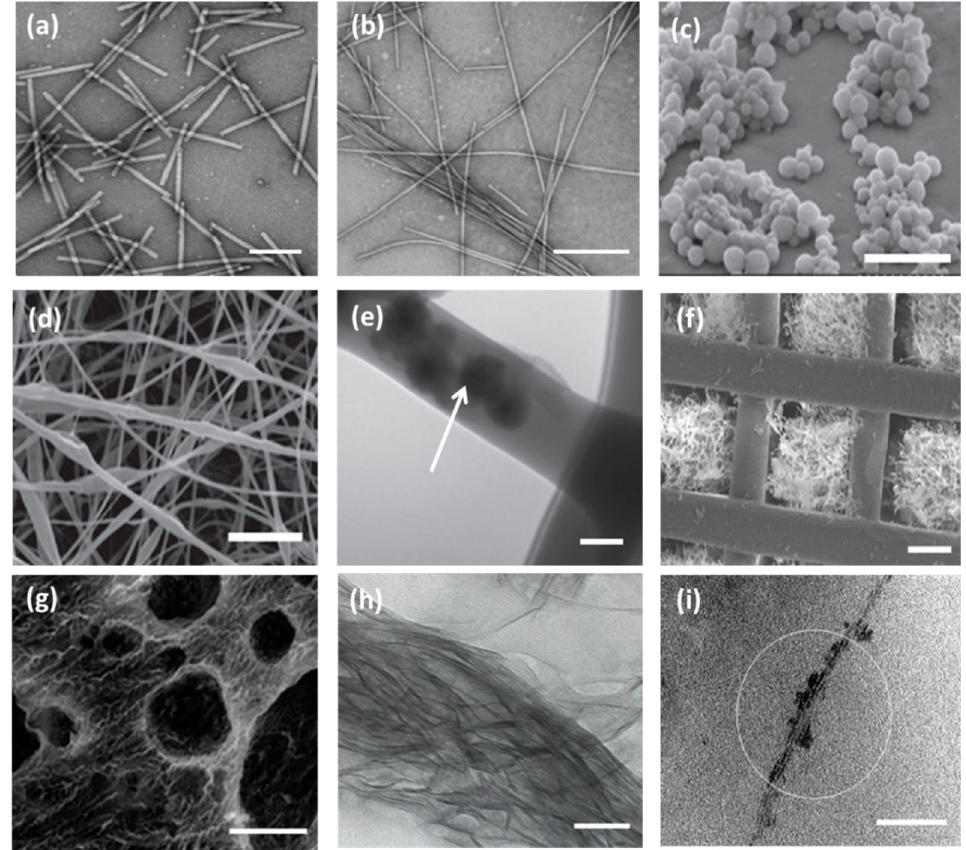
Figure 2. TEM micrographs of wild type Tobacco Mosaic Virus (TMV) nanoparticles, scale bar 200 nm ( a ) and TMV / PANI / PSS nanofiber ( b ) generated by flow assembly method, scale bar 500 nm. Reproduced with permission from [56]. Copyright American Chemical Society, 2015. ( c ) SEM micrograph of freeze-dried capsules of T4 bacteriophage / alginate water in oil emulsion in chloroform, scale bar 5 µ m. ( d ) SEM and TEM micrographs ( e ) of PEO electrospun nanofiber containing T4 bacteriophage / alginate have been shown scale bars of 10 µ m and 100 nm, respectively. The arrow indicates the presence of T4 / alginate into the nanofiber. Reproduced with permission from [57]. Copyright John Wiley and Sons, 2013. ( f ) SEM image of the 3D printed bioceramic bone scaffold consisting of biphasic calcium phosphate with pores filled with a matrix of chitosan and RGD phage, scale bar 200 µ m. Reproduced with permission from [58]. Copyright John Wiley and Sons, 2014. ( g ) SEM micrograph of porous alginate hydrogel containing TMV particles displaying interconnected channels and macropores, scale bar 100 µ m. Reproduced with permission from [59]. Copyright American Chemical Society, 2012. ( h ) The TEM image of a mineralized E8-displaying phage bundle formed after 90 h incubation in the solution containing calcium and phosphate ions, scale bar 100 nm. Reproduced with permission from [60]. Copyright John Wiley and Sons, 2010. ( i ) The TEM image of the HAP-fd phage bundle with scale bar 100 nm. The circle indicates the presence of hydroxyapatite